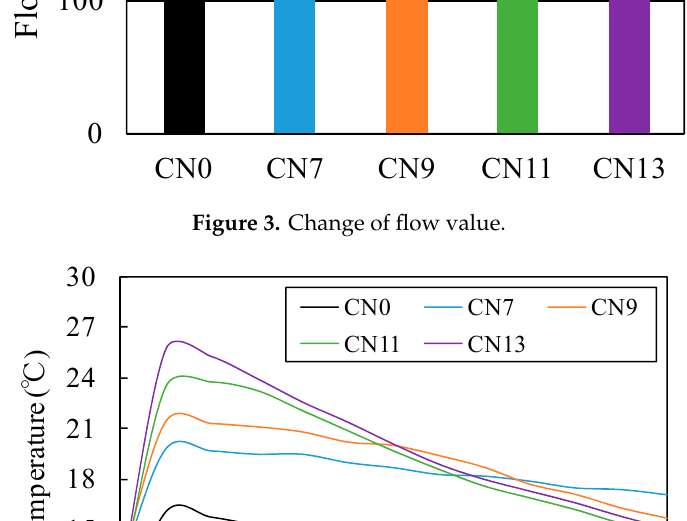
Figure 4. Temperature history (2 h).